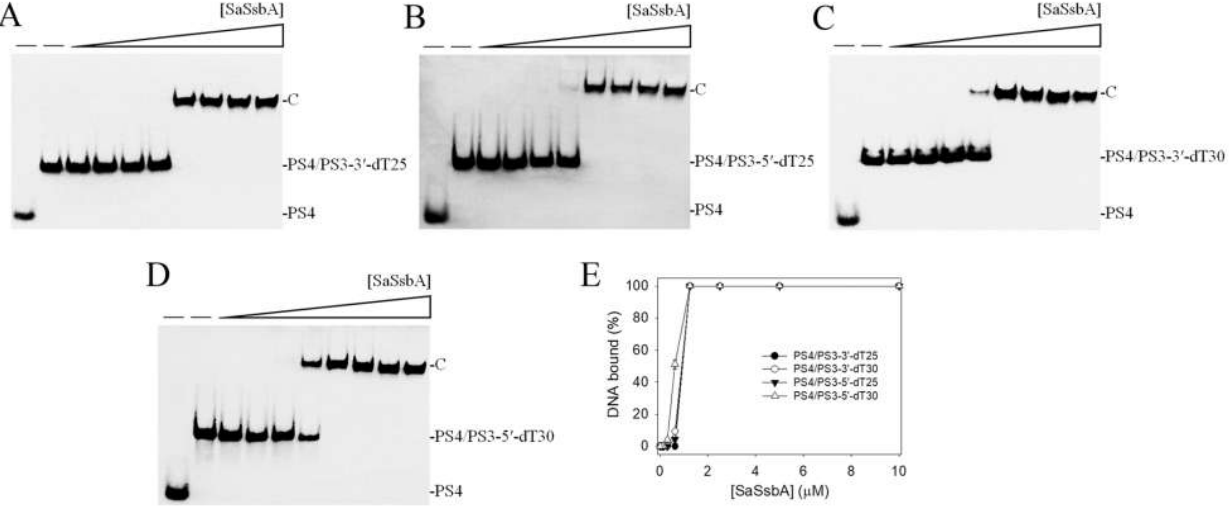
Figure 2. Binding of SaSsbA to dsDNA with ssDNA overhang. Purified SaSsbA (0, 0.078, 0.156, 0.312, 0.625, 1.25, 2.5, 5, 10 μM) was incubated with ( A ) PS4/PS3-3′-dT25, ( B ) PS4/PS3-5′-dT25, ( C ) PS4/PS3-3′-dT30, and ( D ) PS4/PS3-5′-dT30 at 37 °C for 60 min. ( E ) DNA-binding abilities of SaSsbA. The binding constants ([Protein] 50 ) were quantified through linear interpolation based on the protein concentration.